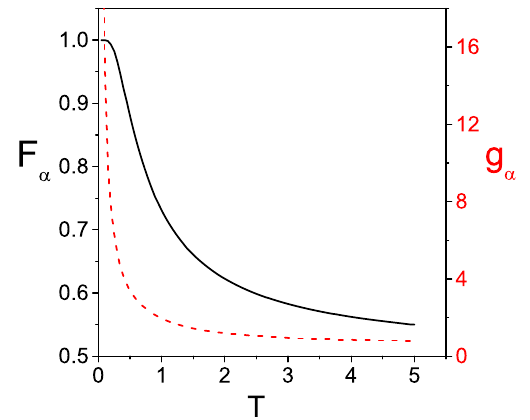
Fig. 3 The decoherence of F α and G α is illustrated by the black line and red dash line respectively. The parameters of α = π/ 4 and ω = 1 are chosen